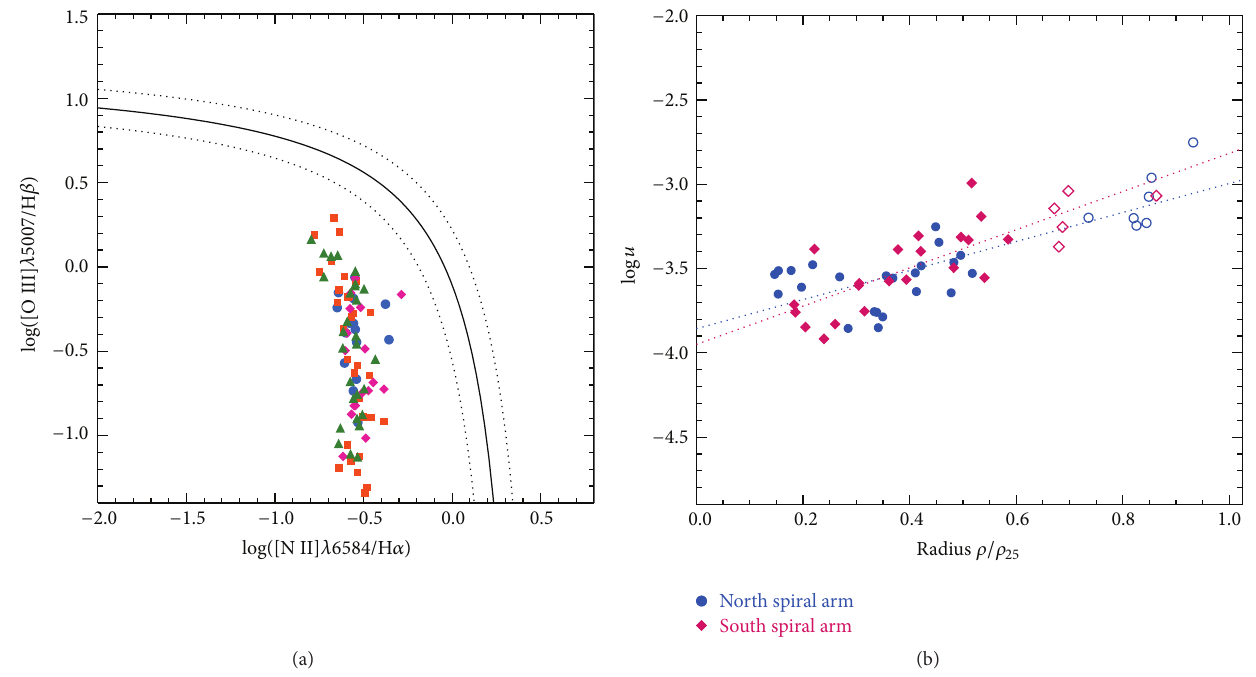
Figure 4: (a) BPT diagnostic diagram for HII regions coded according to the geometric position (quadrants) with respect to the an arbitrary axis drawn across the galaxy surface. The locus of different sectors does not show a clear trend or do not populate a clearly visible region on any diagram, compared to the rest of the quadrants. Points from all the regions are equally distributed within the cloud of points on each diagnostic diagram, indicating that the emission line ratios of the HII regions are not a function of azimuthal angle across the disc. (b) Radial gradients of the ionization parameter log 𝑢 for morphologically selected HII regions of NGC 628. The panel shows the log 𝑢 versus 𝜌 relation for the regions belonging to the north and south spiral arms of the galaxy. The difference between the two spiral arms resides in the slope of the gradient of log 𝑢 , for the north arm, and the values of log 𝑢 increase moderately with galactocentric distance, while, for the south arm, the ionization parameter increases with a steeper slope, although within the errors of the linear fittings. Figure adapted from Rosales-Ortega et al.